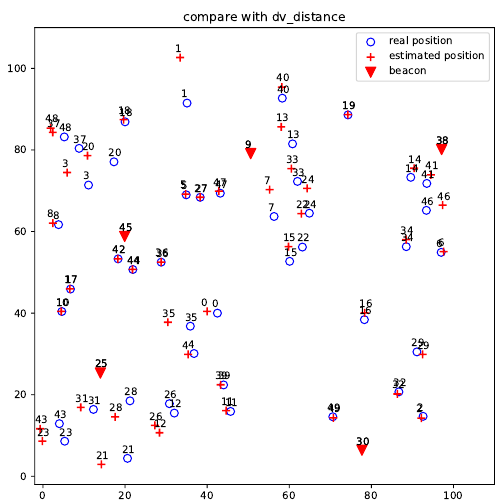
Figure 7. DV-distance localization for the projected 50-node 5-beacon MUWSN on the beacon plane in E 2 .